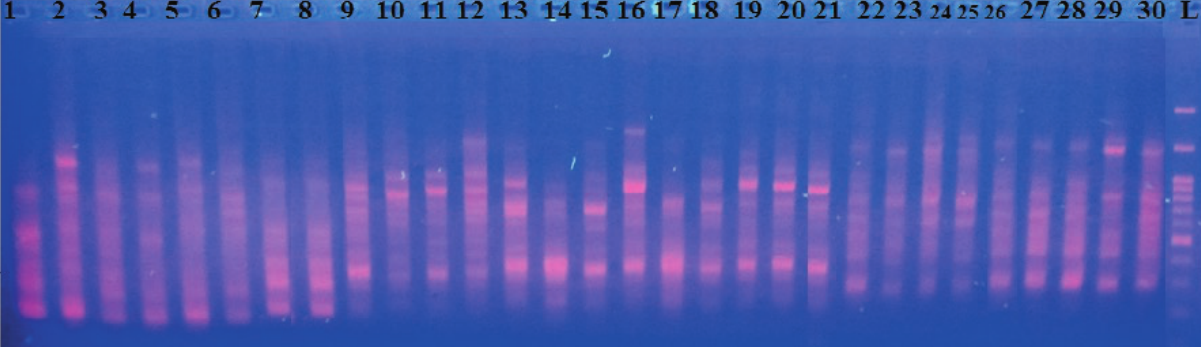
Figure 3. Electrophoresis gel of studied ecotypes from DNA fragments produced by OPD-03. 1= Salvia aristata; 2= S. eremophila; 3= S. santolinifolia ; 4= S. tebesana; 5= S. bracteata ; 6= S. suffruticosa ; 7= S. dracocephaloides ; 8= S. hydrangea; 9= S. multicaulis ; 10: S. syriaca ; 11: S. viridis; 12= S. mirzayanii ; 13= S. macrosiphon; 14= S. sharifii; 15= S. reuterana; 16= S. palaestina; 17= S. sclareopsis; 18= S. spinose; 19= S. compressa; 20= S. sclarea; 21= S. aethiopis; 22= S. microstegia; 23= S. xanthocheila; 24= S. limbata ; 25= S. chloroleuca ; 26= S. virgate; 27= S. nemorosa; 28= S. urmiensis ; 29= S. oligphylla; 30= S. verticillata; L = Ladder 100 bp, Arrows are representative of polymorphic